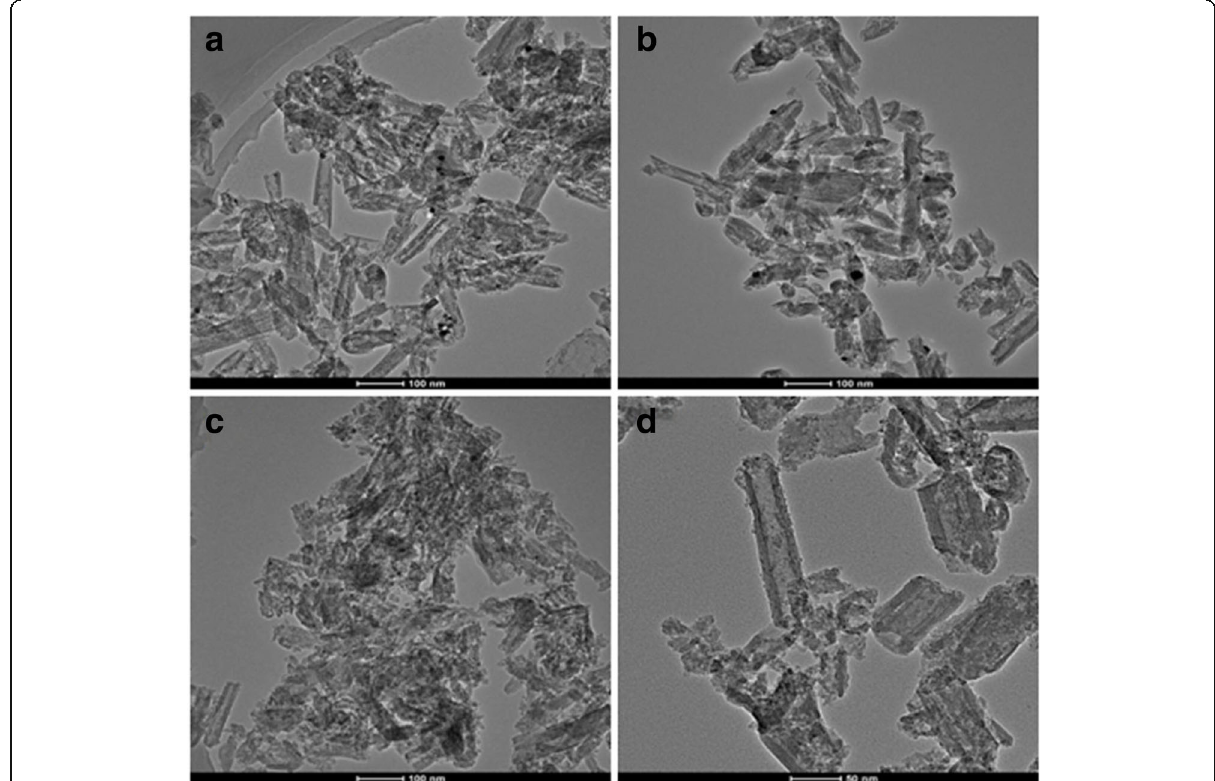
Fig. 5 TEM images of a Pd-H3-MOFs(Zn), b Pd-H3-MOFs(Al), c Pd-C-H3-MOFs(Zn), and d Pd-C-H3-MOFs(Al) samples